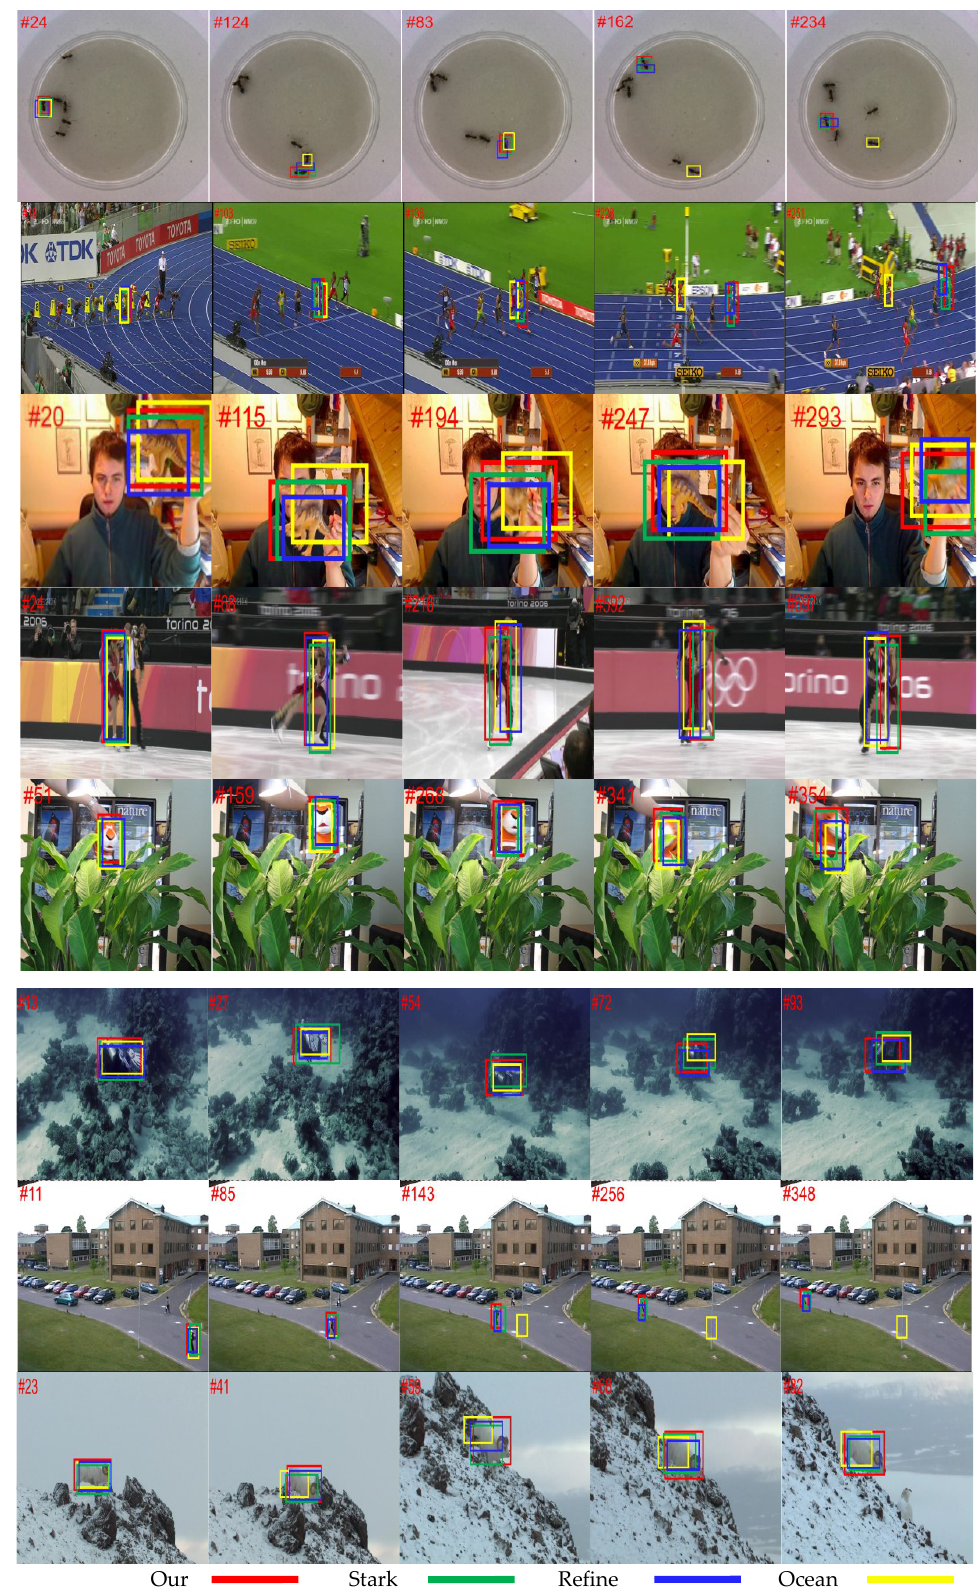
Figure 5. The qualitative results on five challenging sequences.